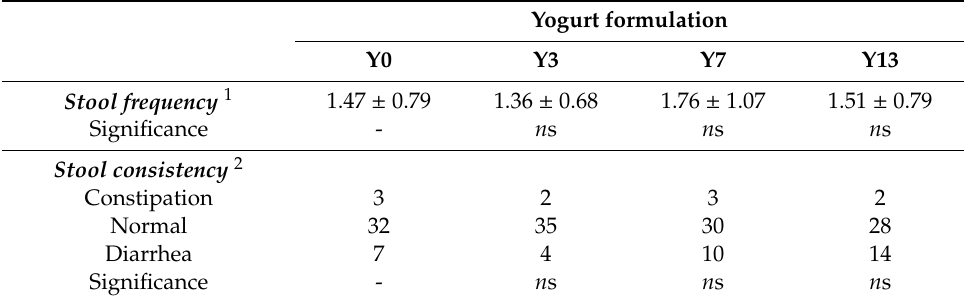
Table 4. Stool frequency and consistency within 2 to 24 h following the consumption of the yogurt treatments in healthy adults ( n =